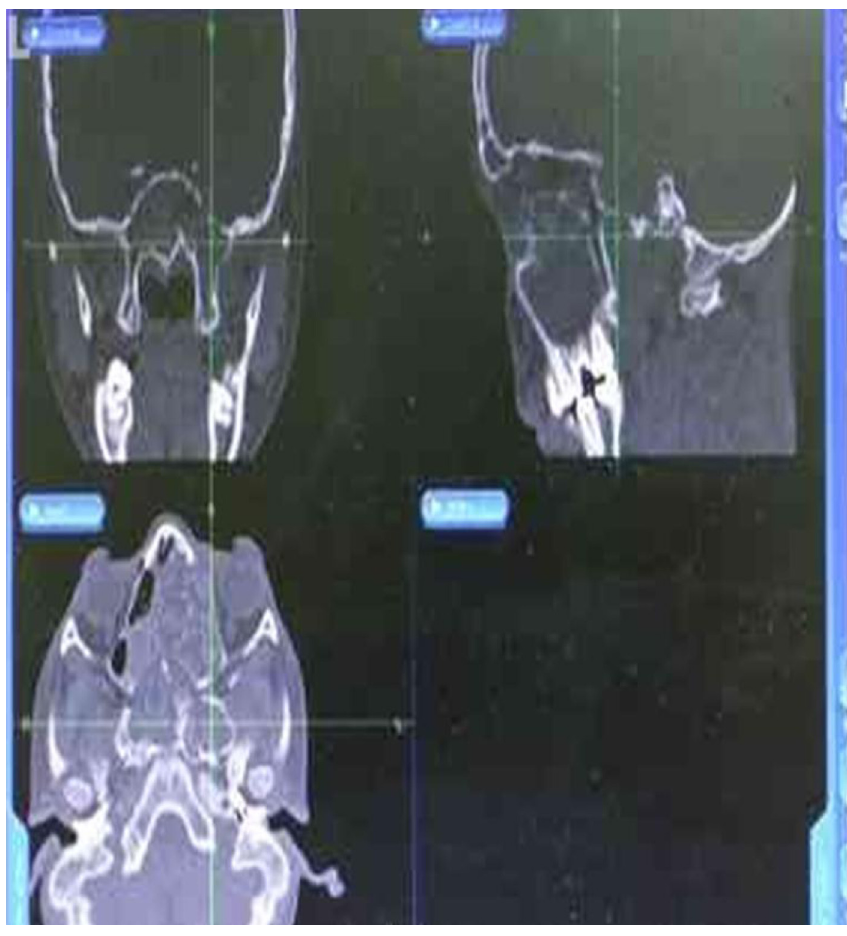
Figure 1 Navigation image showing site of